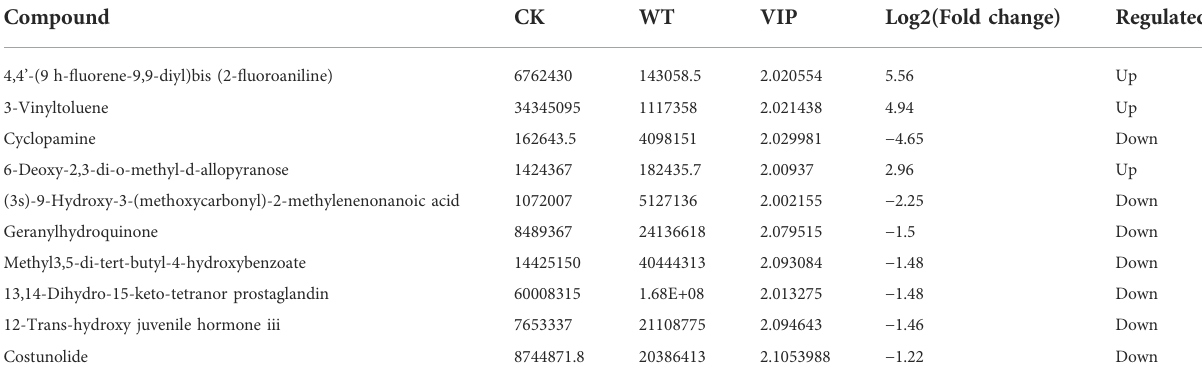
TABLE 1 List of top 10 metabolites by variable importance for fold change and VIP value.